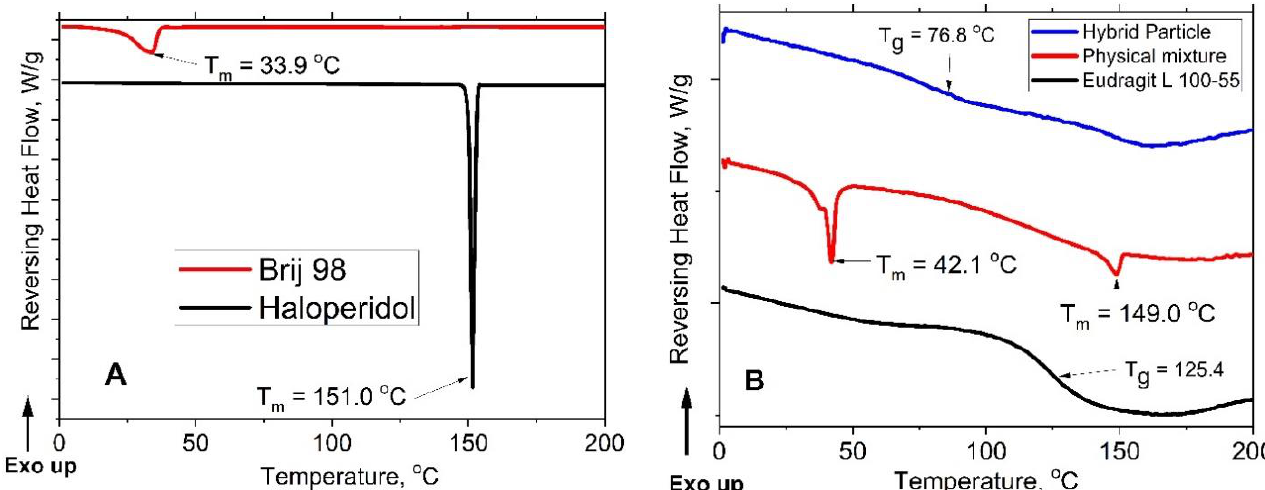
Figure 6. DSC thermograms: ( A ) Brij 98 and haloperidol, and ( B ) L100-55, a physical mixture of haloperidol, Brij 98 and L100-55 and hybrid nanoparticles.